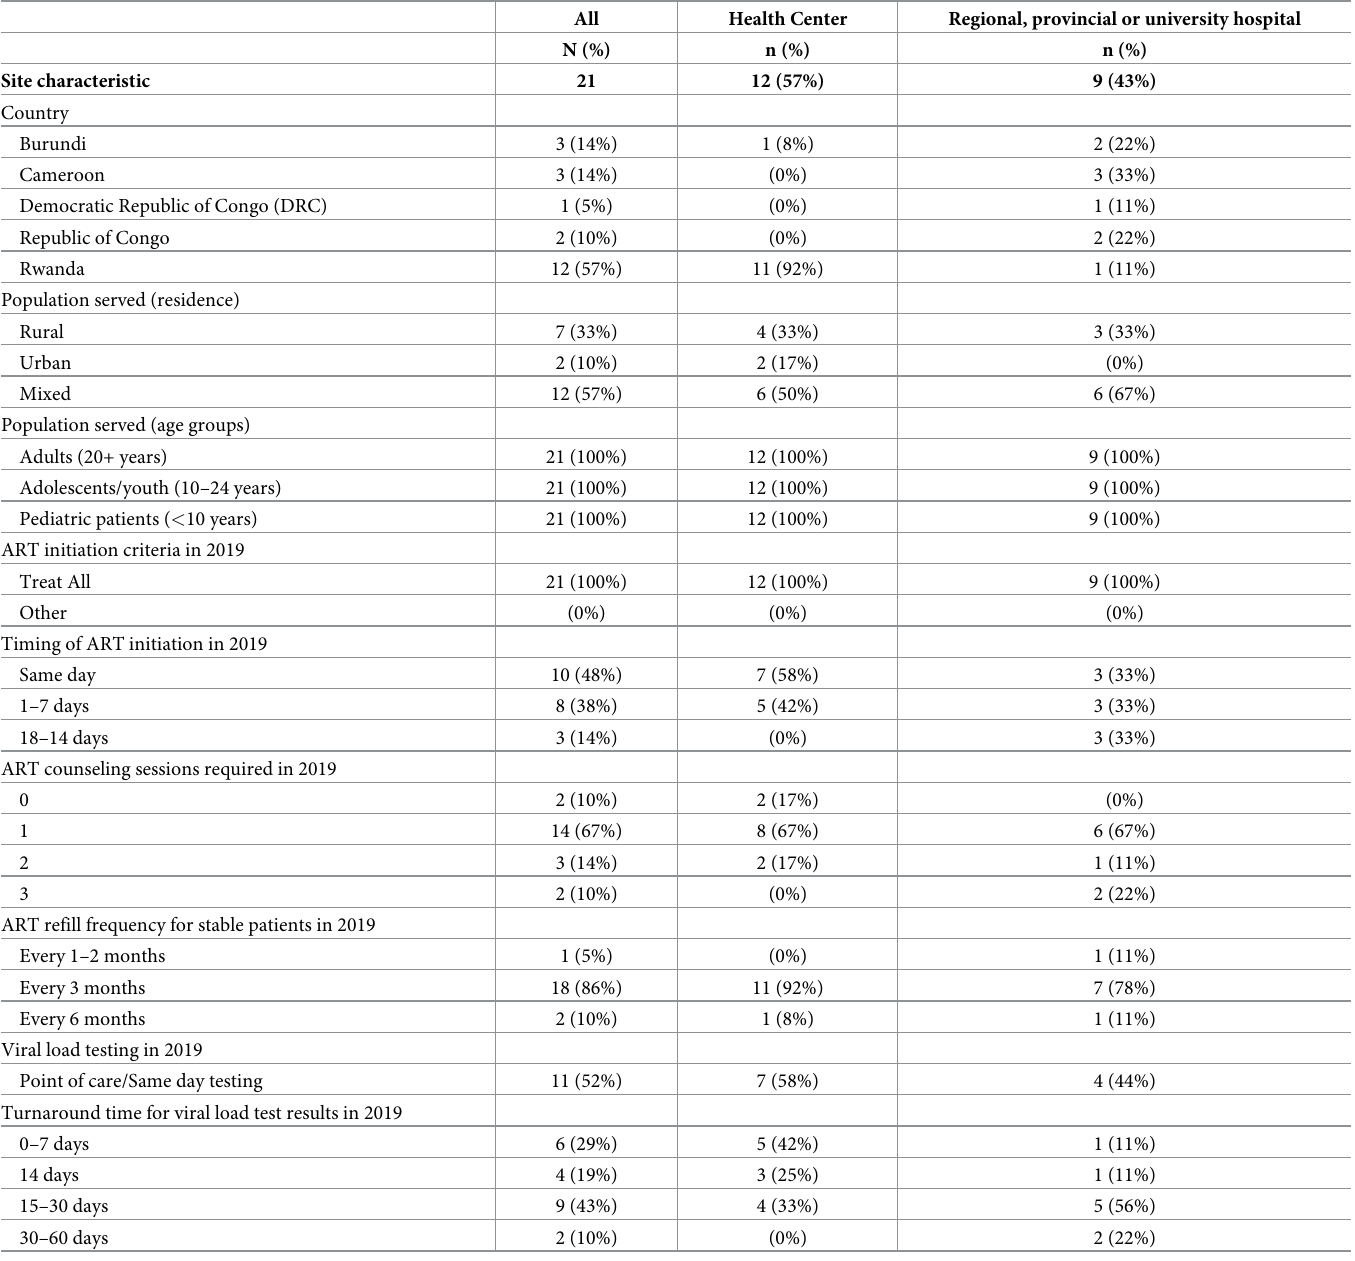
Table 1. Characteristics of Central Africa IeDEA sites.